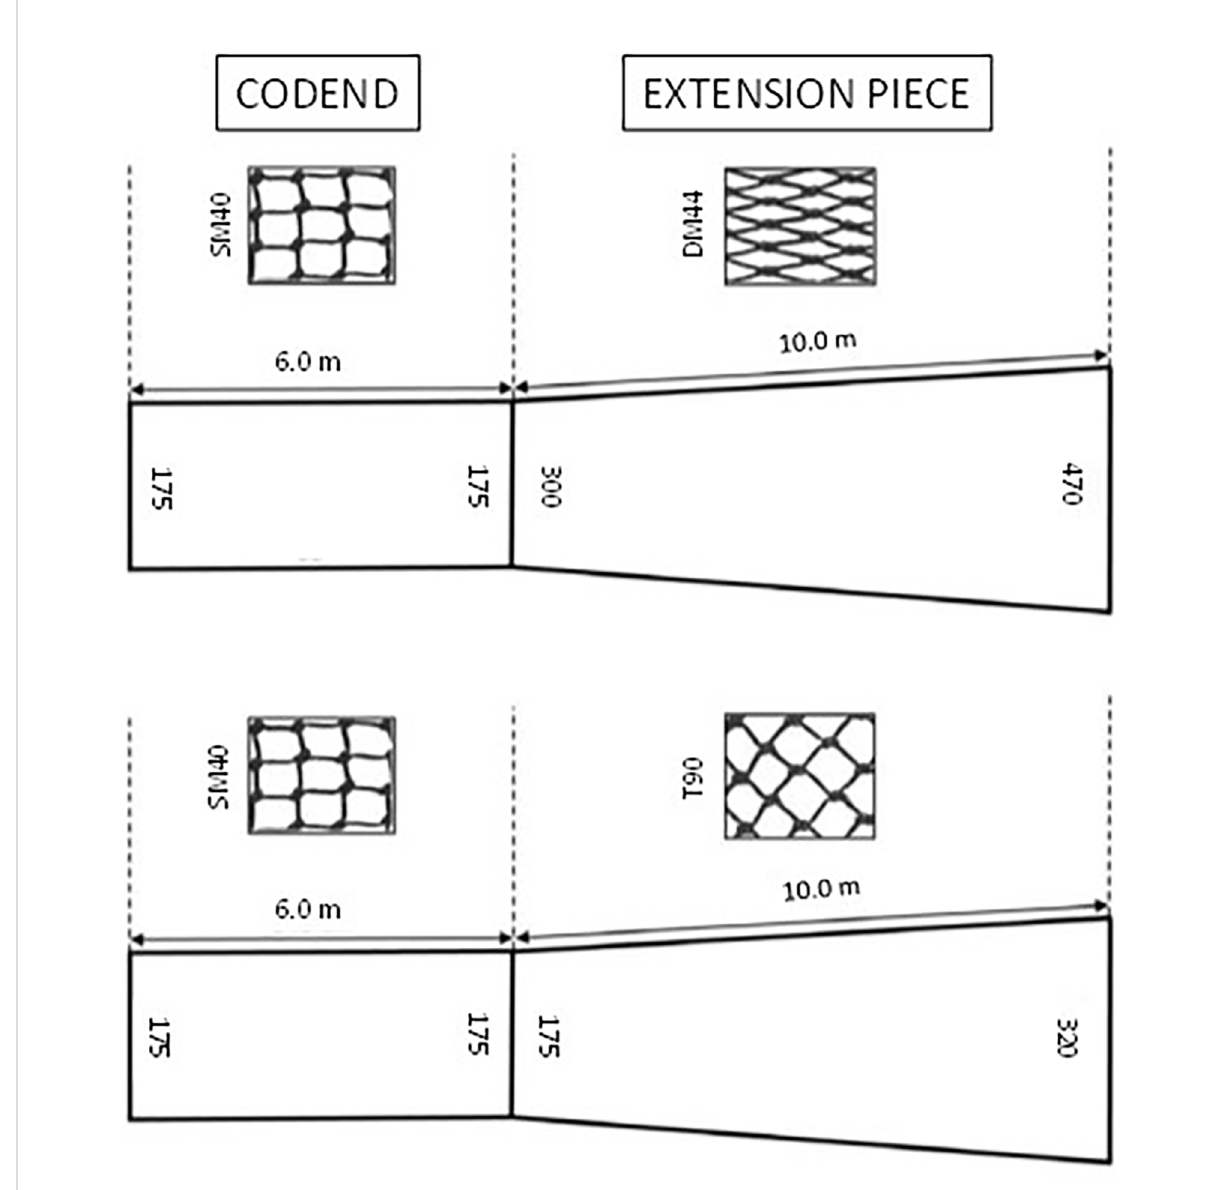
FIGURE 4 Scheme of the structure of cod-end and extension piece in the CTRL (above) and the T90 (below) nets (from Sola and Maynou, 2018a; modi fi ed). SM40: 40 mm square mesh. DM44: 44 mm diamond